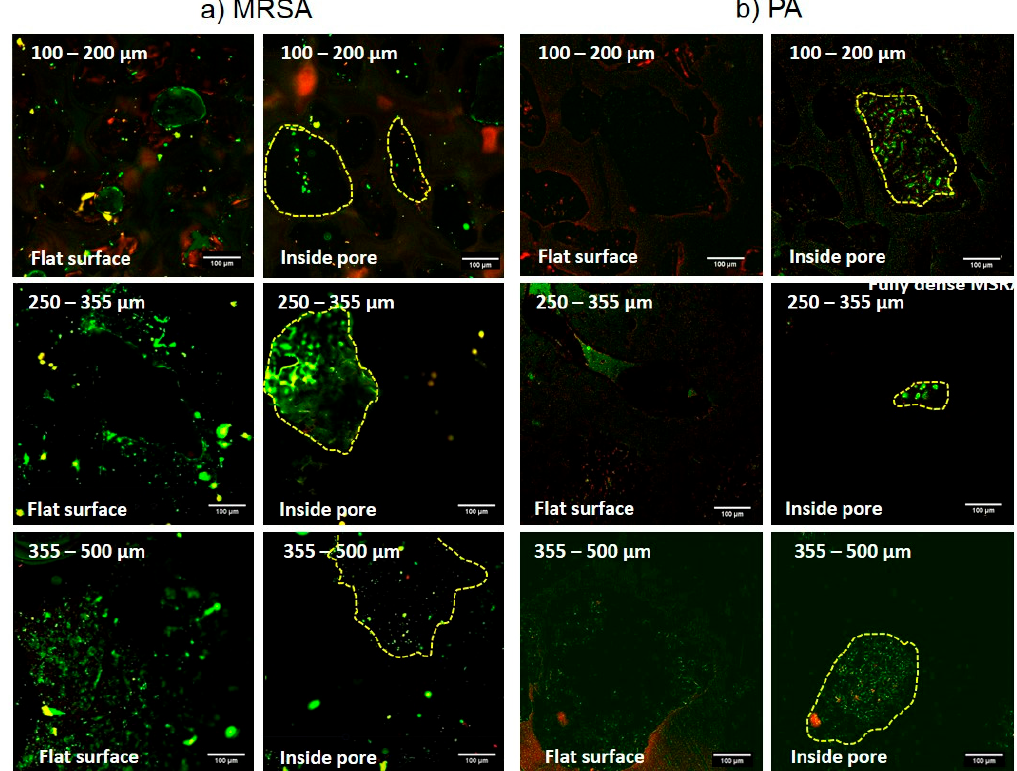
Figure 9. Confocal microscopy study of live and dead MRSA ( a ) and PA ( b ) on flat and pore surfaces for the three different porous uncoated substrates. Green fluorescence represents alive bacteria, while red dots represents dead bacteria and yellow damaged cells.